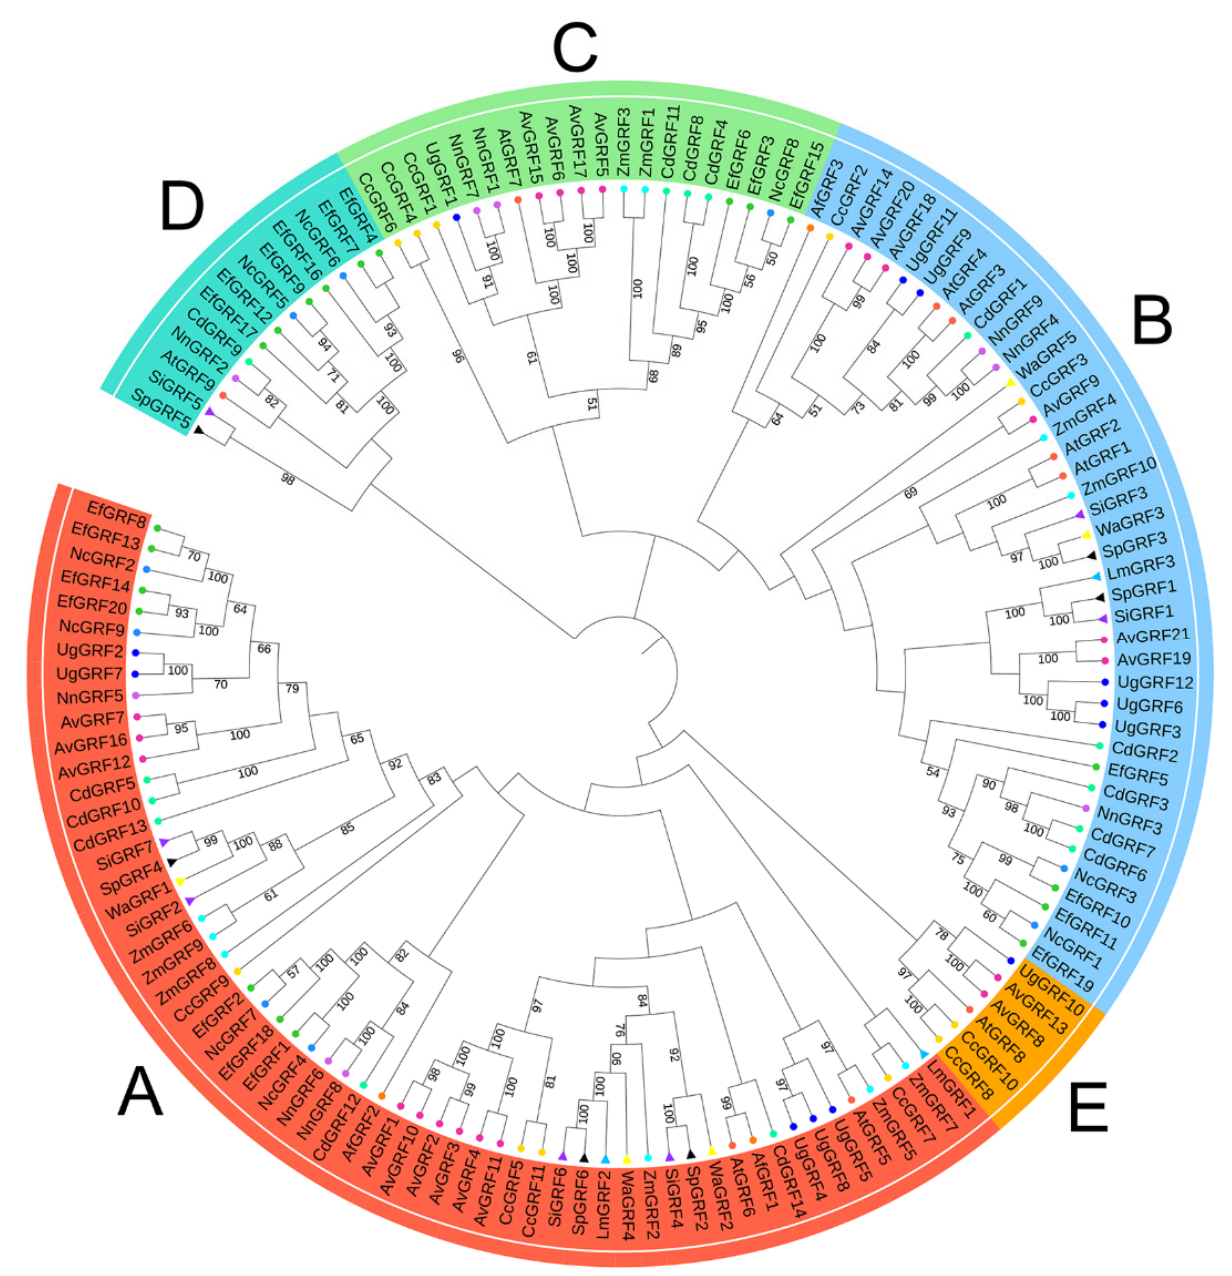
Figure 2. Phylogenetic analysis of the GRFs in A. thaliana and 13 aquatic plants. The neighbor-joining (NJ) phylogenetic tree was generated by MEGA 7.0 with 1000 bootstrap replications on the JTT model. The 139 GRFs were divided into five groups ( A – E , named by numbers of genes and indicated by five different colors), and the GRFs from different species were labeled with different colored symbols. Tomato circles indicate genes from A. thaliana ; Dark orange circles indicate genes from A. filiculoides ; Maroon circles indicate genes from A. vesiculosa ; Gold circles indicate genes from C. chinensis ; Yellow circles indicate genes from C. demersum ; Dark gold circles indicate genes from E. ferox ; Blue circles indicate genes from U. gibba ; Dodger blue circles indicate genes from N. colorata ; Medium orchid circles indicate genes from N. nucifera ; Cyan circles indicate genes from Z. marina ; Deep sky blue triangles indicate genes from L. minuta ; Purple triangles indicate genes from S. intermedia ; Black triangles indicate genes from S. polyrhiza ; Yellow triangles indicate genes from W. australiana .